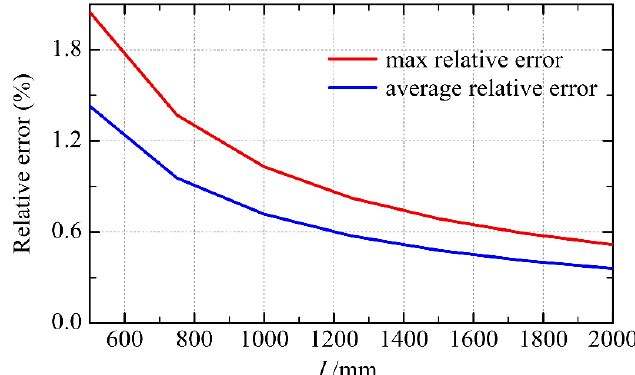
Figure 14. The change in average relative error and maximum relative error of corrected emissivity with l .